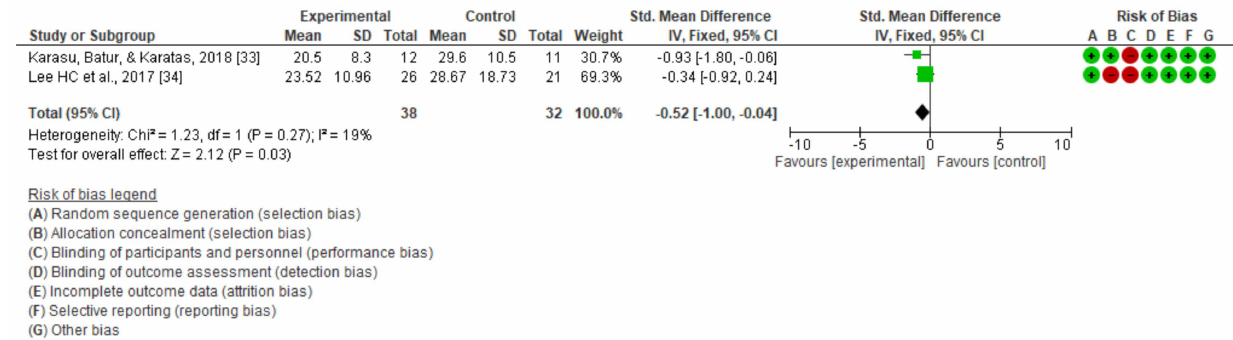
Figure 10. Meta-analysis of follow-up on dynamic balance.